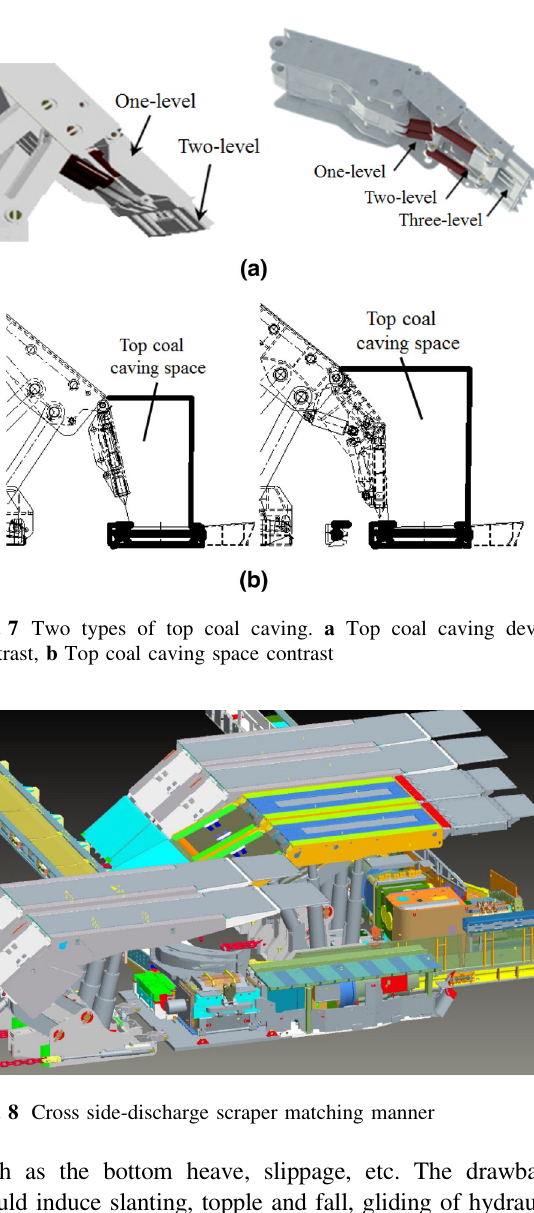
b Fig. 6 Top-coal time-displacement curve due to hydraulic support supporting again and again to top-coal. a Supporting stress 0.3 MPa, b Supporting stress 0.6 MPa, c Supporting stress 0.9 MPa, d support-